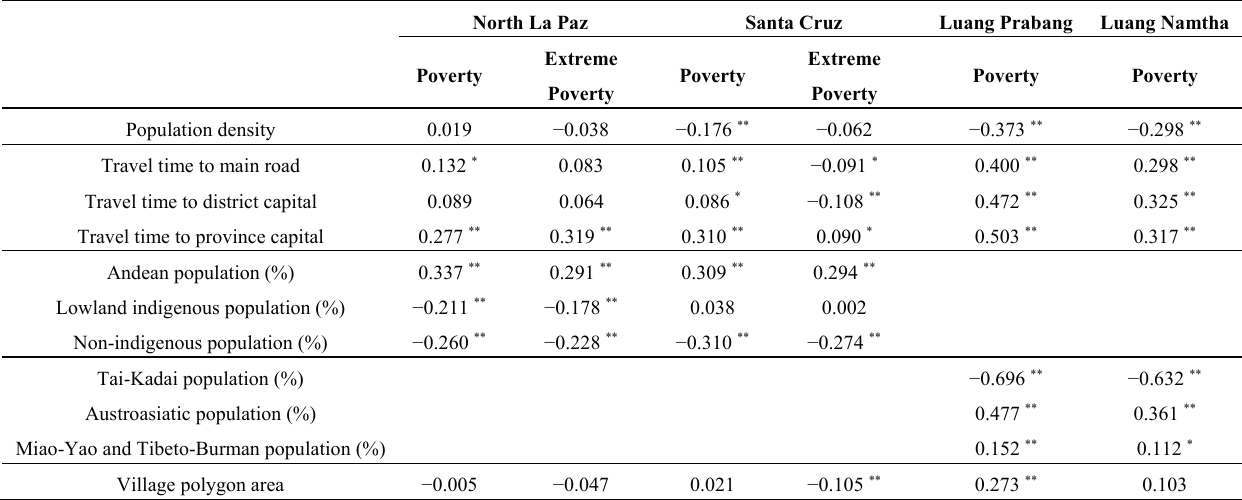
Table 2. Poverty rate in relation with other socio-economic variables.